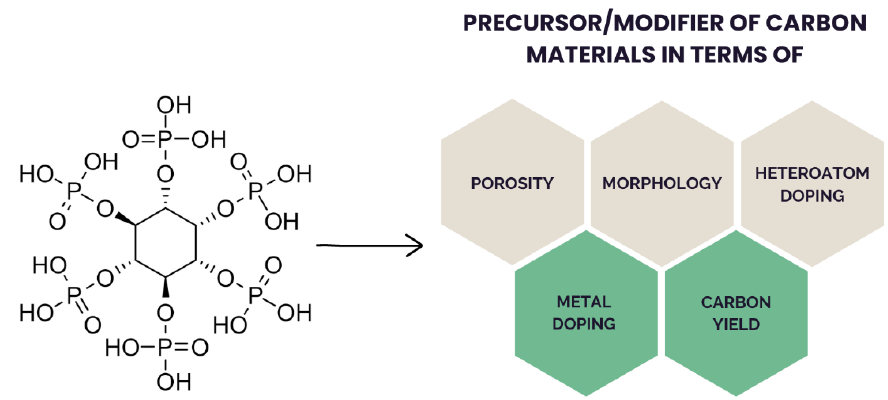
Figure 2. Structure of PA and its possible influence on the derived carbon materials.